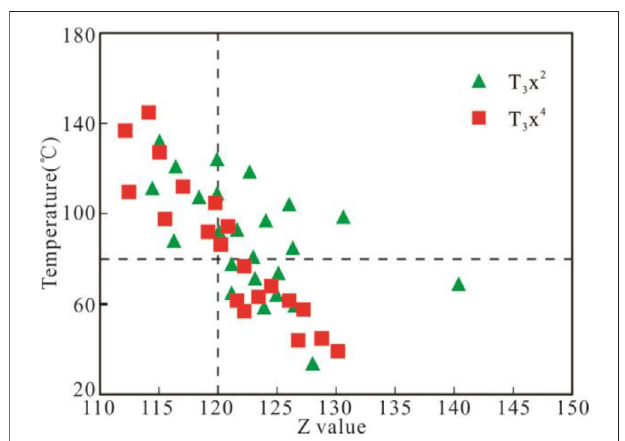
FIGURE 8 | Relationship between the Z value of carbonate cement and temperature in the target